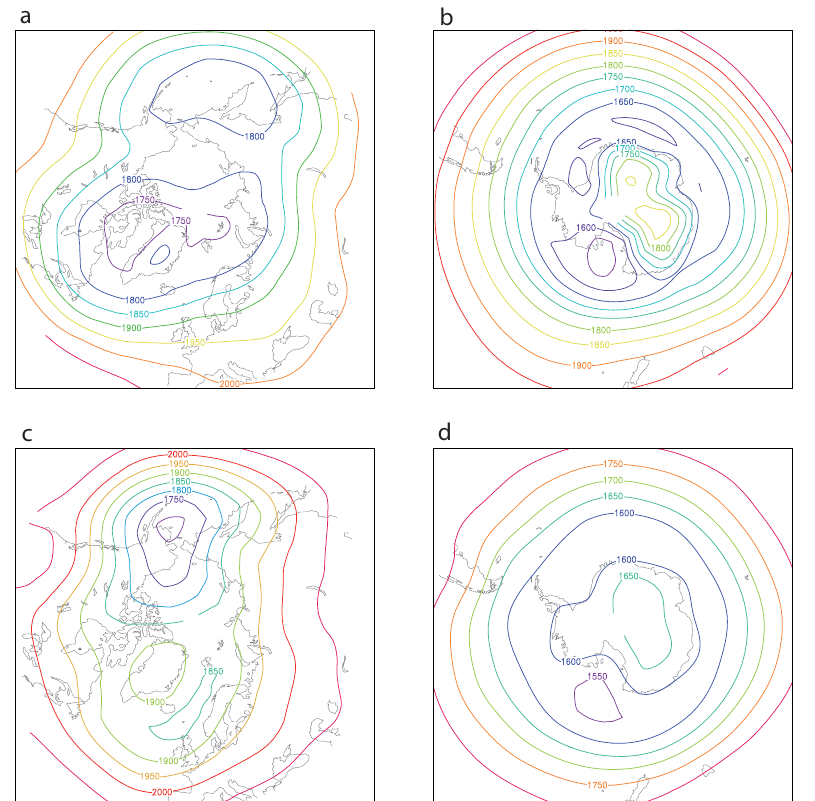
Fig. 11. Geopotential height (in m) at 800hPa in winter averaged over the period 1980–2000 (DJF in the Northern Hemisphere, JJA in the Southern Hemipshere) in NCEP-NCAR reanalyses (Kalnay et al., 1996, top row, i.e. a and b ) and in LOVECLIM1.2 (bottom row, i.e. c and d ).